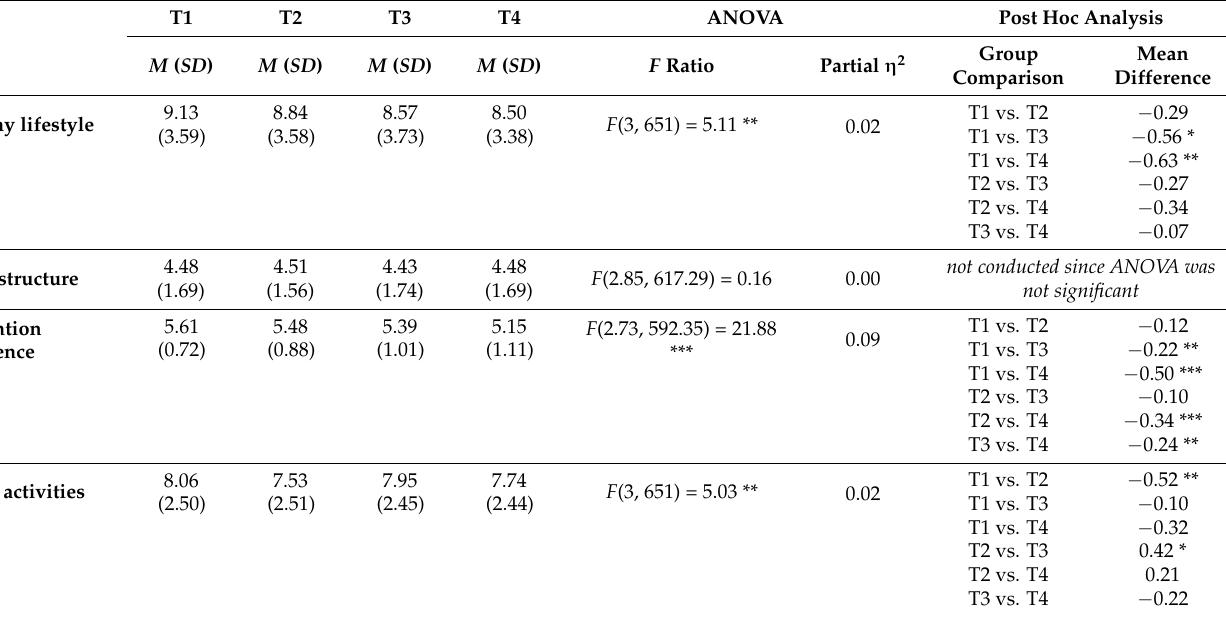
Table 7. Means, standard deviations, and repeated measures ANOVA statistics for pandemic-related coping behaviors.